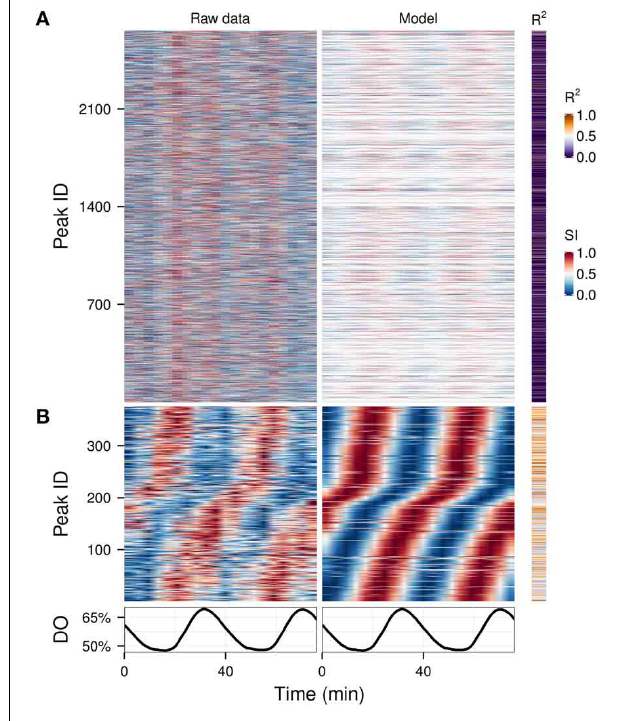
FIGURE 5 | Exploratory examination of a noisy time-series metabolomics dataset. A time-series dataset of unidentified CE-MS peaks ( A , left panel) (Sasidharan et al., 2012b) was filtered using the waveform algorithm with default cut-off and targeting the dominant frequency of the data (2 cycles; A , right panel). The statistically significant peaks based on the coefficient of determination ( R 2 ) are shown in (B) . Peak IDs were sorted using hclust (stats package in R) (Murtagh, 1985) with the euclidean distance and Ward’s method (Ward, 1963) in (A) and by the phase angle of the 2-cycle component in (B) . The corresponding dissolved oxygen (DO) trace during the experiment is show in bottom panel. The temporal profile of each peak was scaled (SI) for visualization